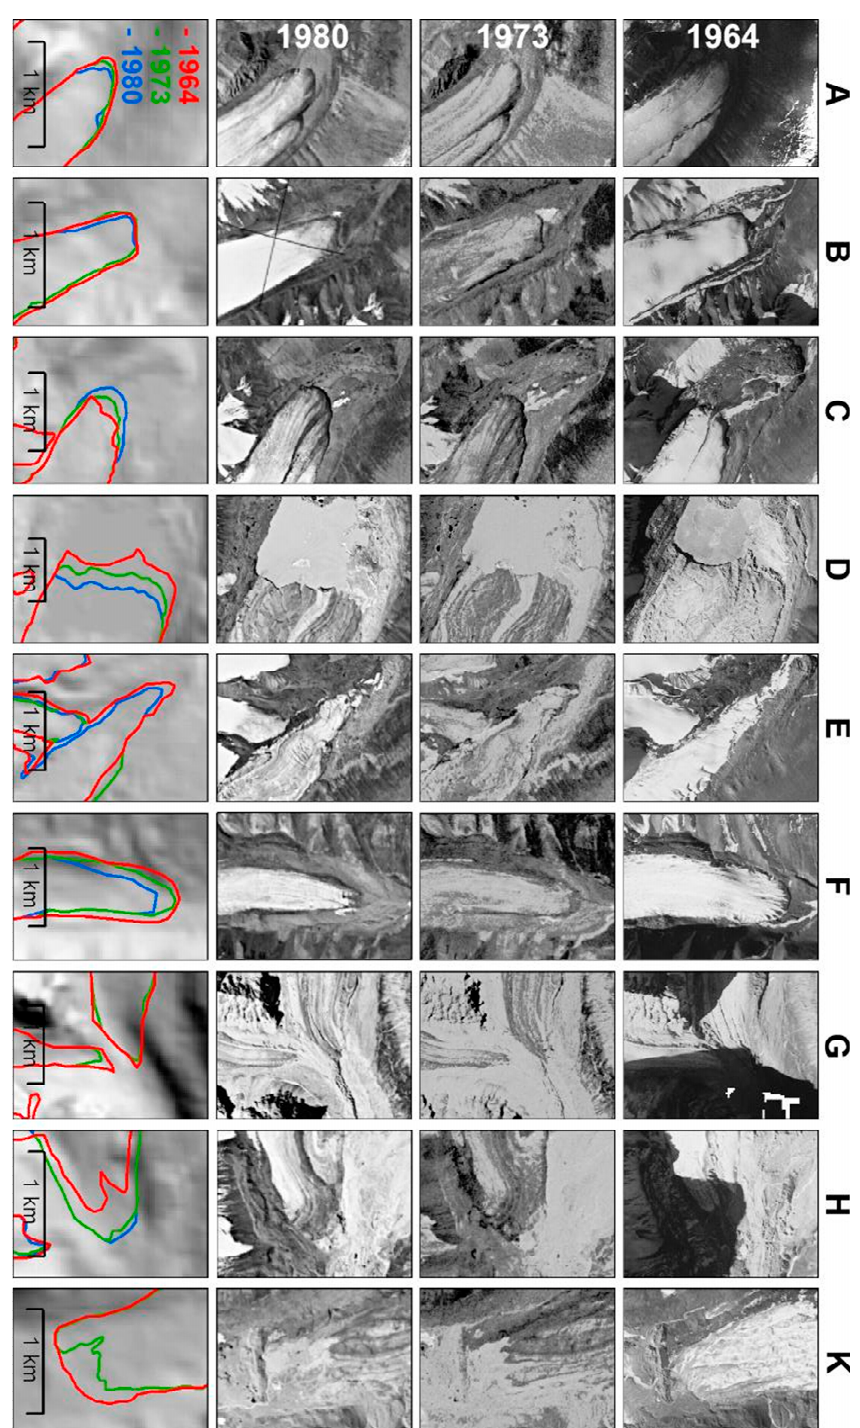
Figure 8. Glacier tongue changes of individual glaciers on Corona KH-4A (1964), Hexagon KH-9 (1973 and 1980): ( A ) Bordu South (354); ( B ) Sary-Tor South; ( C ) Davidov; ( D ) Petrov; ( E ) Sary-Tor North; ( F ) Besimjannij; ( G ) Dschamansu; ( H ) Kaindy; and ( K ) Kara-Say North.